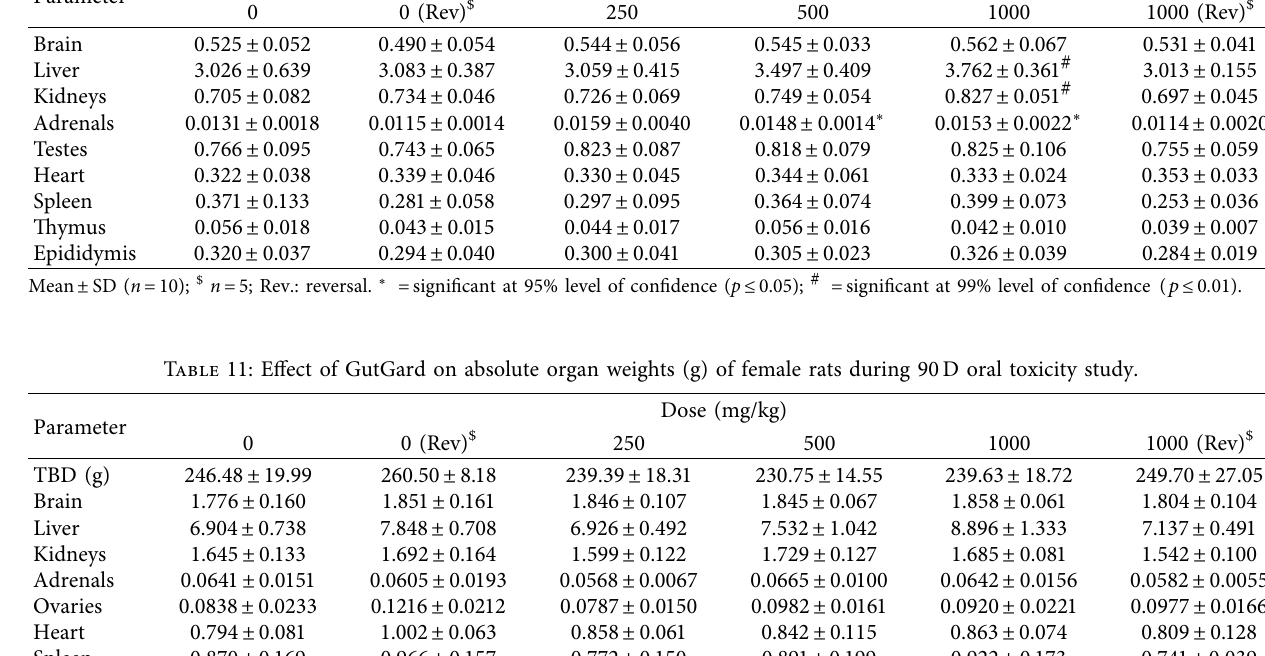
Table 10: Effect of GutGard on relative organ weights (%) of male rats during 90D oral toxicity study. Parameter